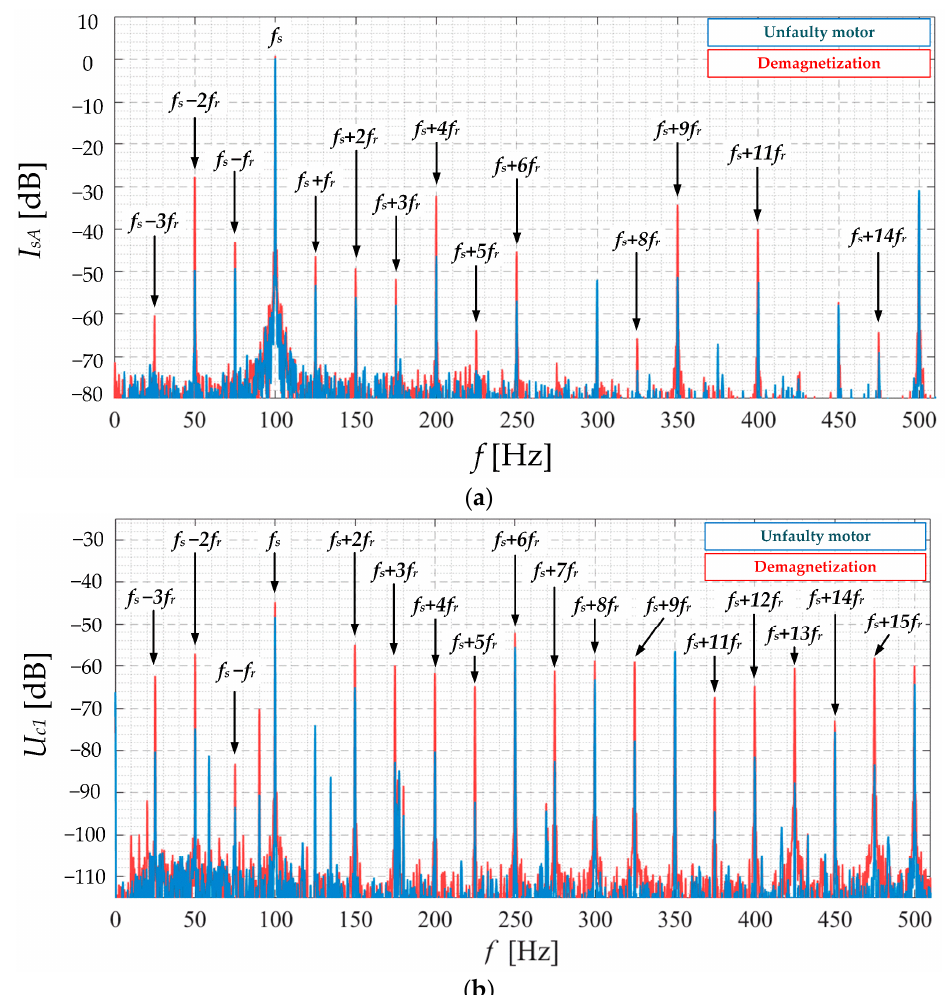
Figure 2. Analysis of the phase current ( a ) and axial flux ( b ) spectrum during partial demagnetiza- tion of PMSM rotor. of PMSM